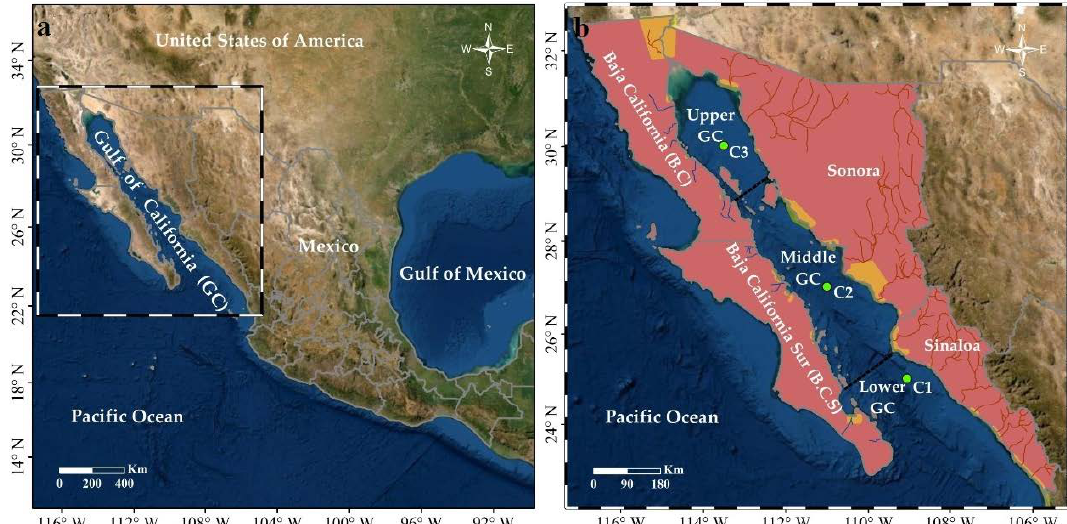
Figure 1. Study area: ( a ) macro-location; ( b ) micro-location, indicating the high population density, as well as the main economic activities including tourism, agriculture, aquaculture and all sorts of fisheries (yellow shading), the river network (undammed river in blue and dammed river in red), and the location of the three wave data sources (C1, C2 and C3).